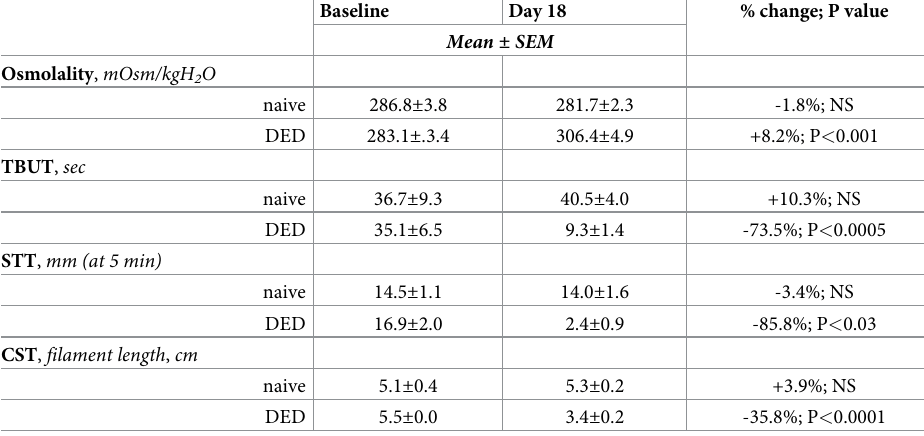
Table 1. ConA-induced dry eye disease in